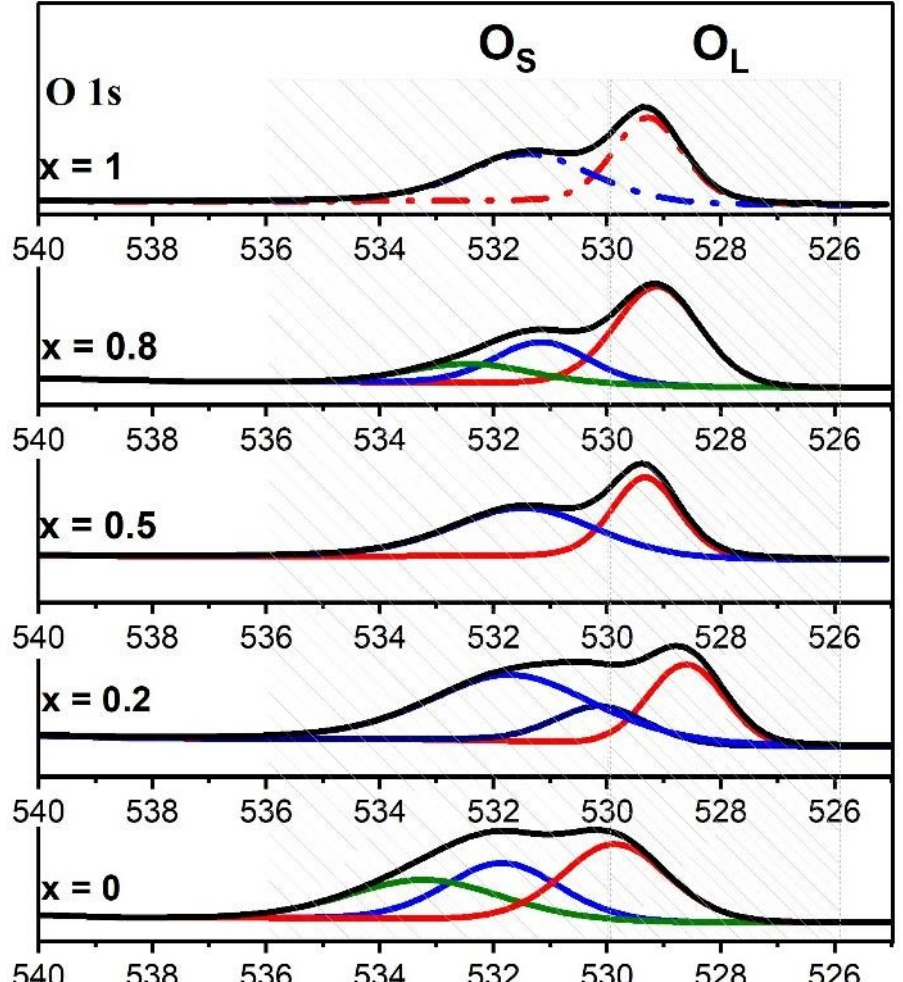
Figure 4. O1s spectra for compounds GdCo x Fe 1 − x O 3 (x = 0; 0.2; 0.5; 0.8; 1) [33].